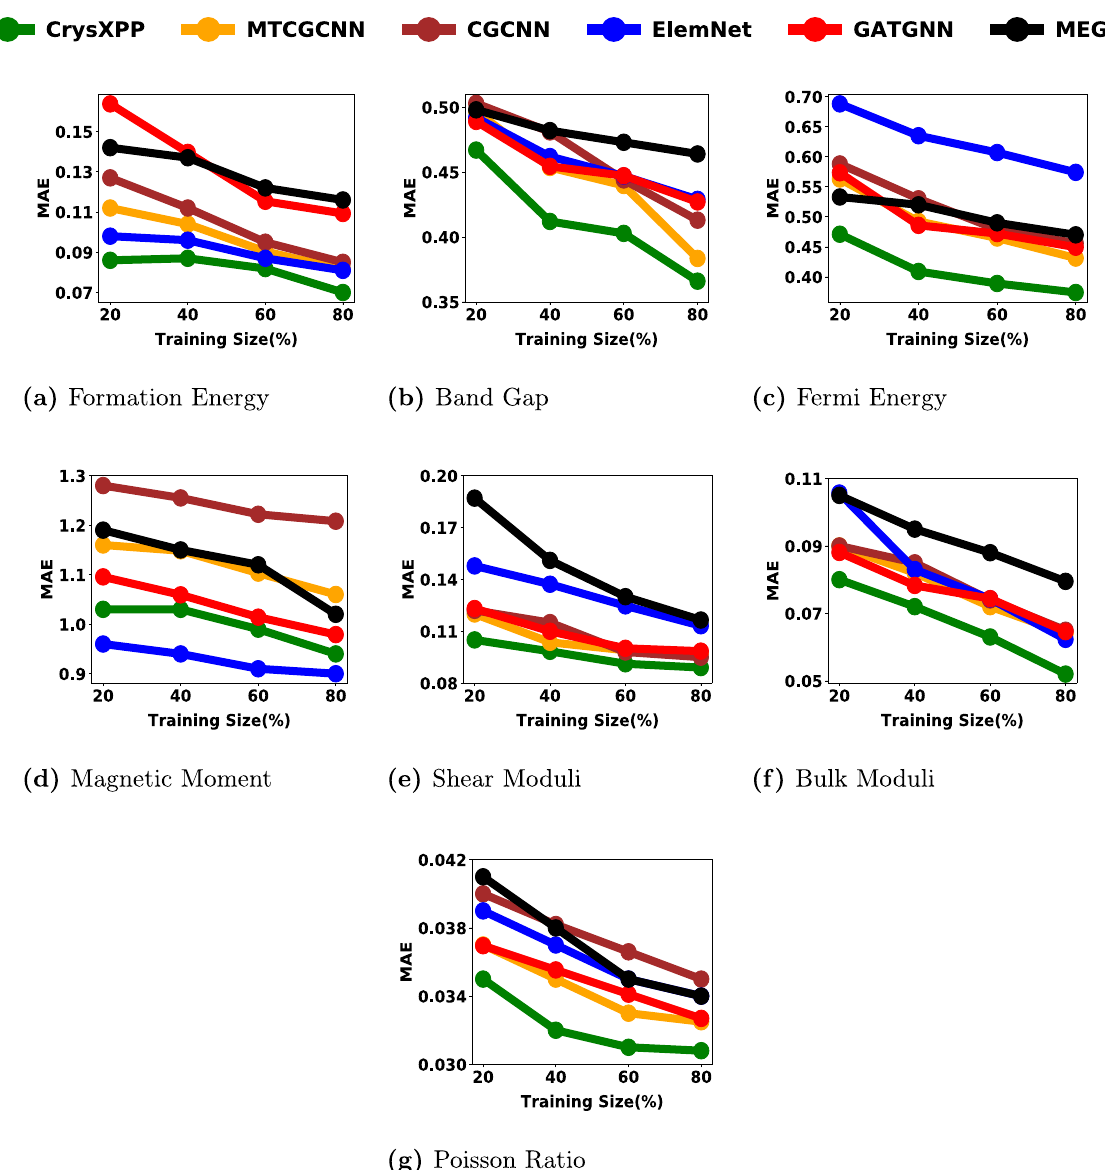
Fig. 3 Variation of MAE with the increase in training instances from 20 to 80%. CrysXPP outperforms all the baselines consistently. a Formation energy. b Band Gap. c Fermi Energy. d Magnetic Moment. e Shear Moduli. f Bulk Moduli. g Poisson